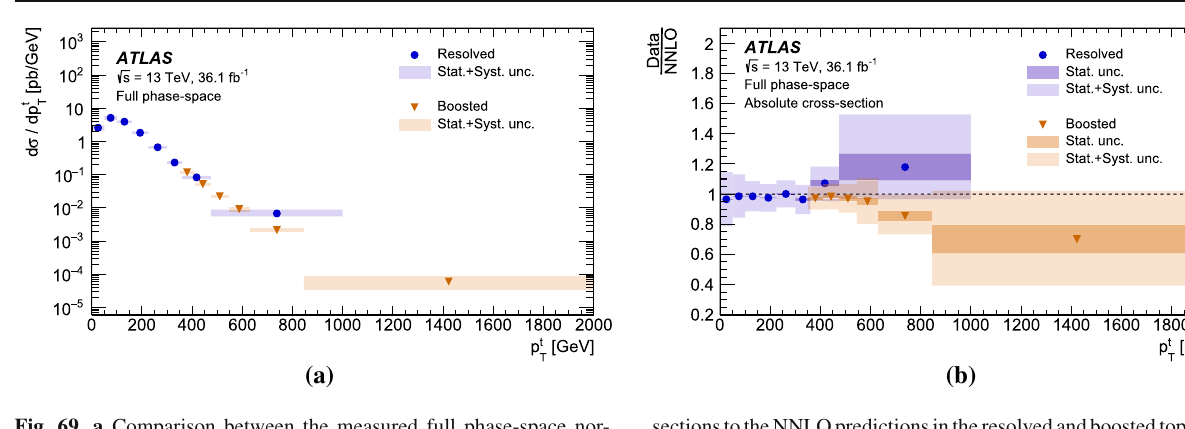
sectionstotheNNLOpredictionsintheresolvedandboostedtopologies as a function of the transverse momentum of the top quark. The bands indicate the statistical and total uncertainties of the data in each